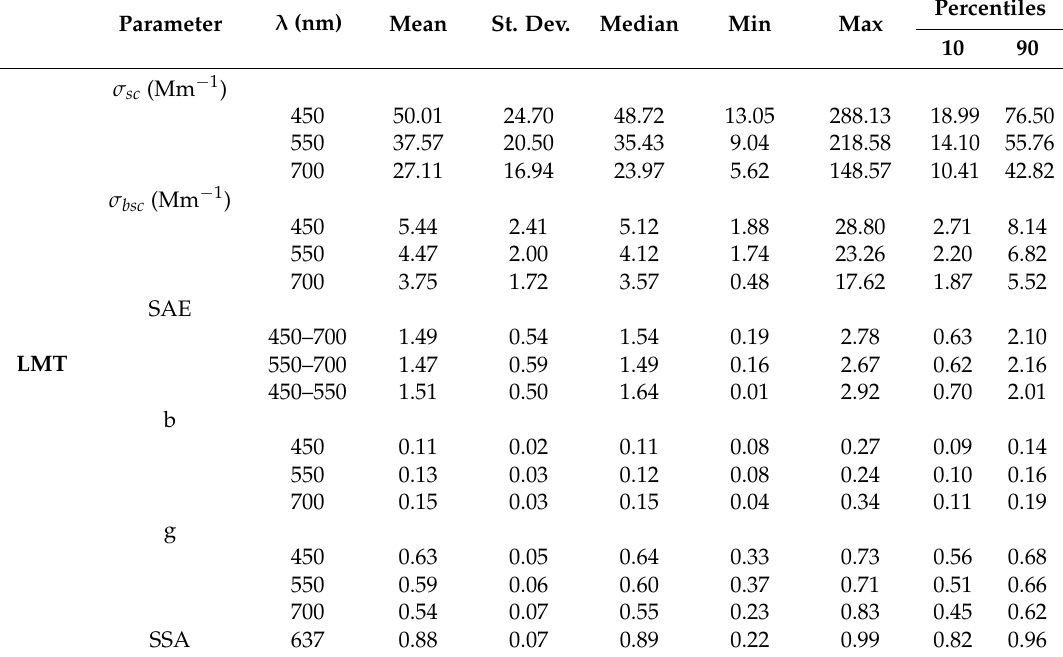
Table 2. Statistical properties (from 5 min average) of the measured and calculated optical properties over the whole period analysed for the LMT observatory.